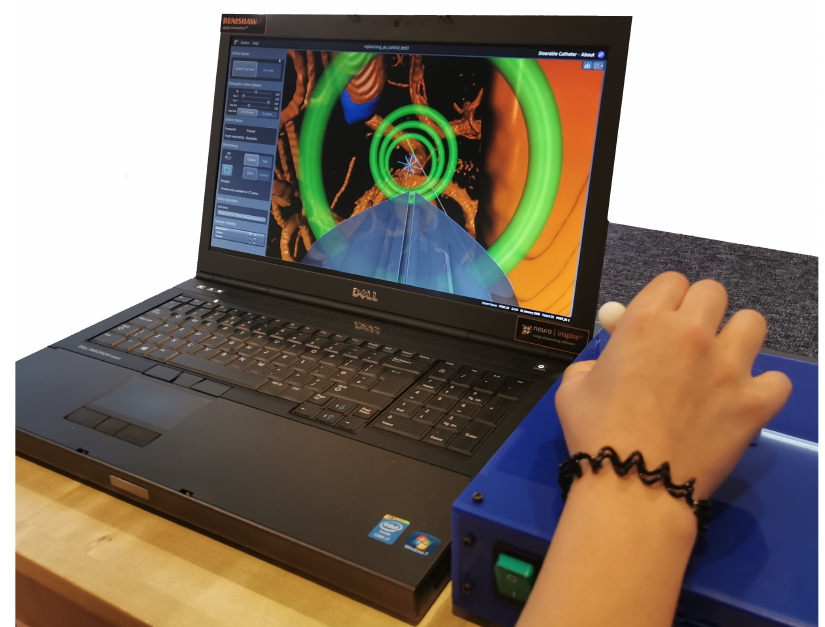
Figure 6. Experimental setup.